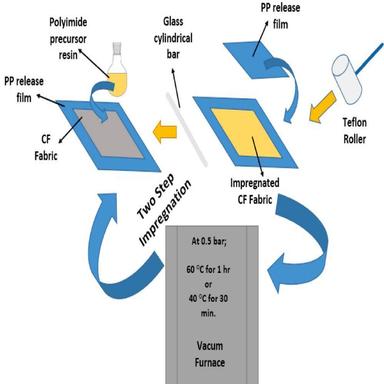
The preparation of the prepregs with two-step impregnation in the vacuum oven.